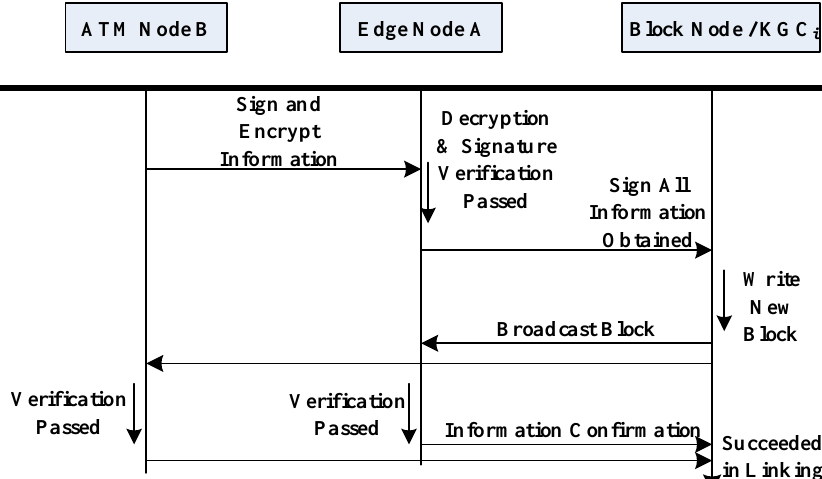
Figure 9. Blockchain-based trustworthy model for information security assurance of networked ATM system.